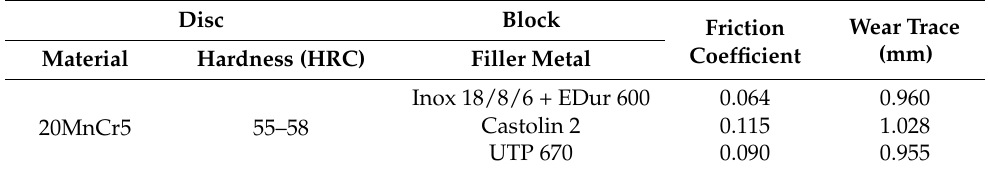
Table 6. The friction coefficients and the wear trace widths for samples hard-faced by different filler metals [12].